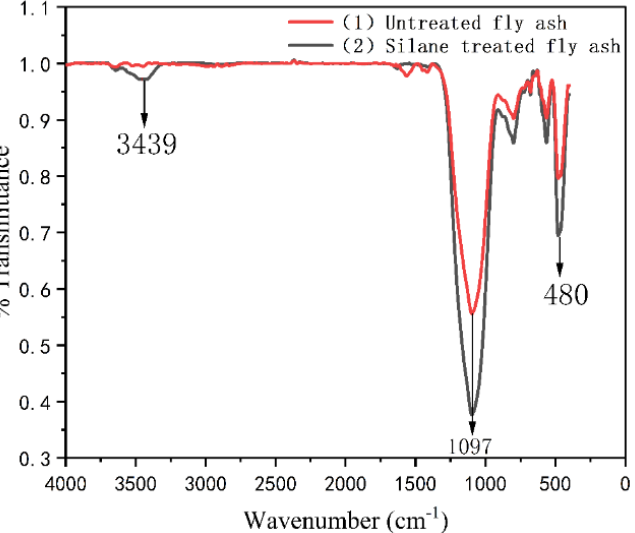
Figure 3. Fourier transform infrared spectroscopy (FT-IR) analysis of silane treated FA and un- treated